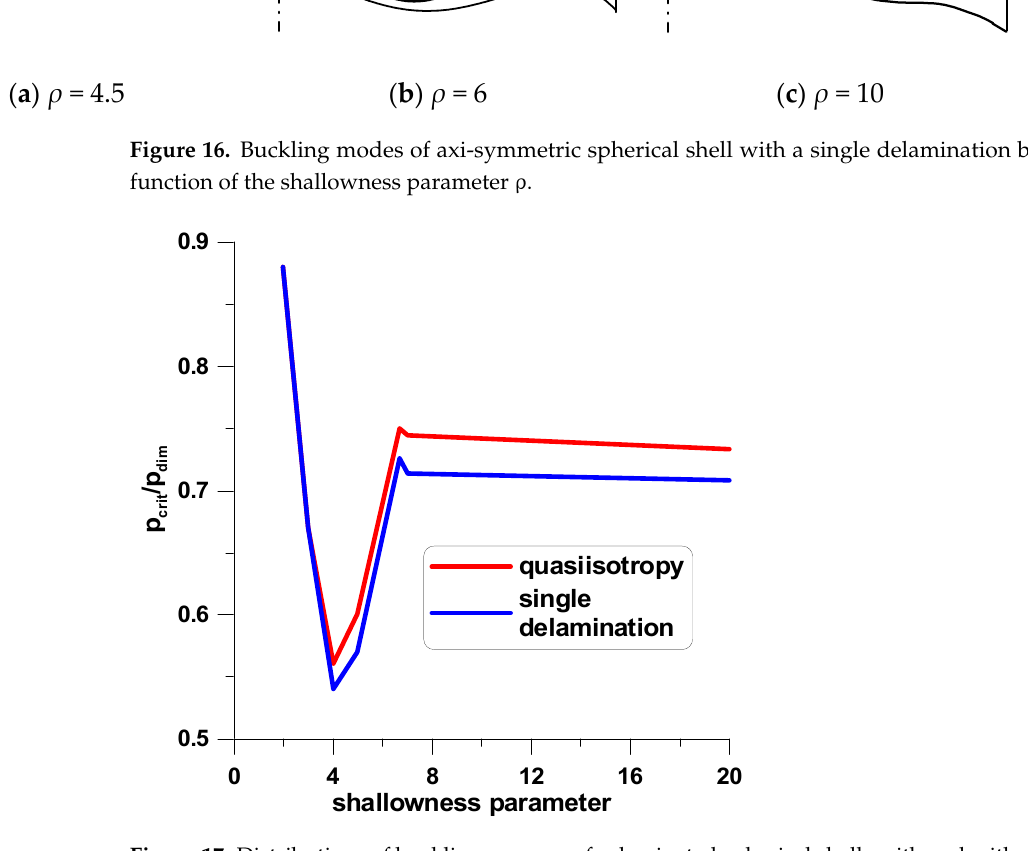
Figure 17. Distributions of buckling pressures for laminated spherical shells with and without single delamination located at the shell mid-surface.